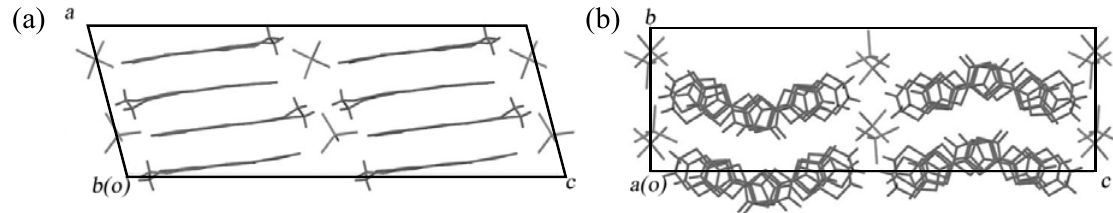
•(FeCl ) along the (a) a − and (b) b − axes. 4 4 2